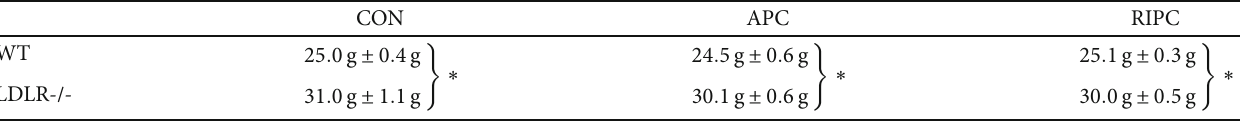
Table 1: The body weight of LDLR-/- mice fed a atherogenic diet was signi fi cantly higher compared to that of the WT mice. CON APC RIPC WT